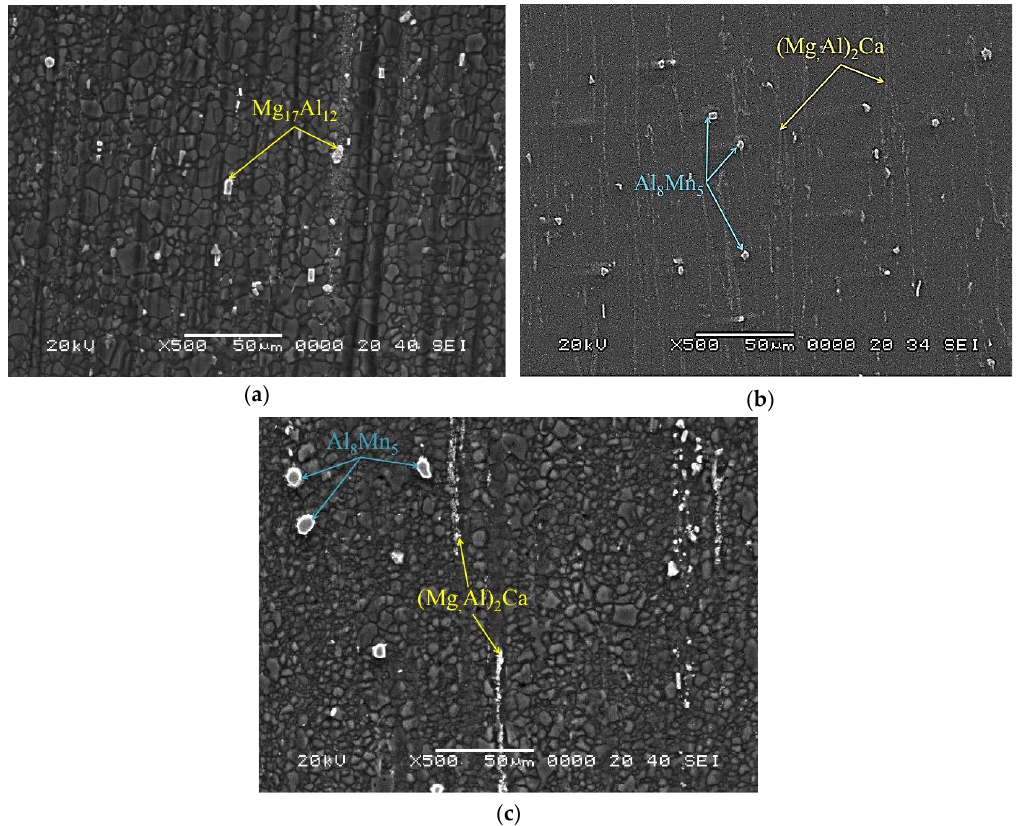
Figure 2. SEM images of initial composites produced by DMD processing and extrusion: ( a ) AZ31-1.5NAl, ( b ) AZ31-1Ca-1.5NAl, and ( c ) AZ31-2Ca-1.5NAl. The extrusion direction is vertical. Table 1. Details of microstructural parameters (1 – 3), (4) temperature – strain rate ranges for domains, (5) peak efficiency ( η ) conditions, (6) apparent activation energy ( Q app ) and (7) tensile elongation, and